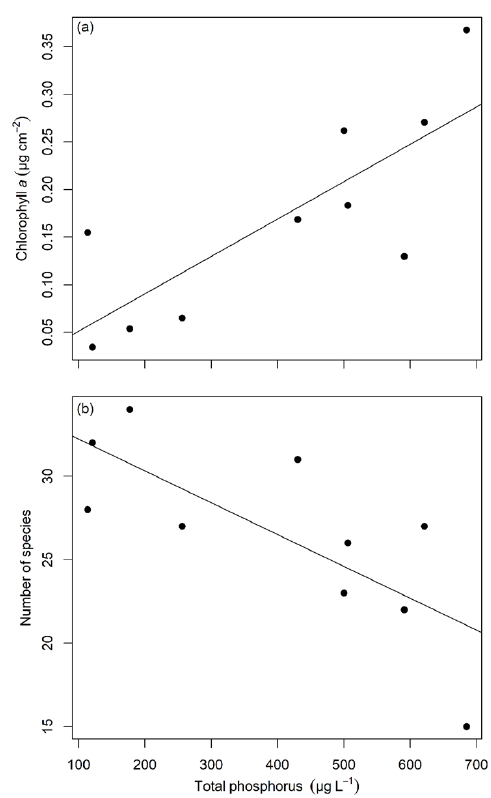
Figure 3. (a) Periphytic biomass represented by chlorophyll- a and (b) species richness of diatoms in relation to the concentrations of total phosphorus in the sampled coastal